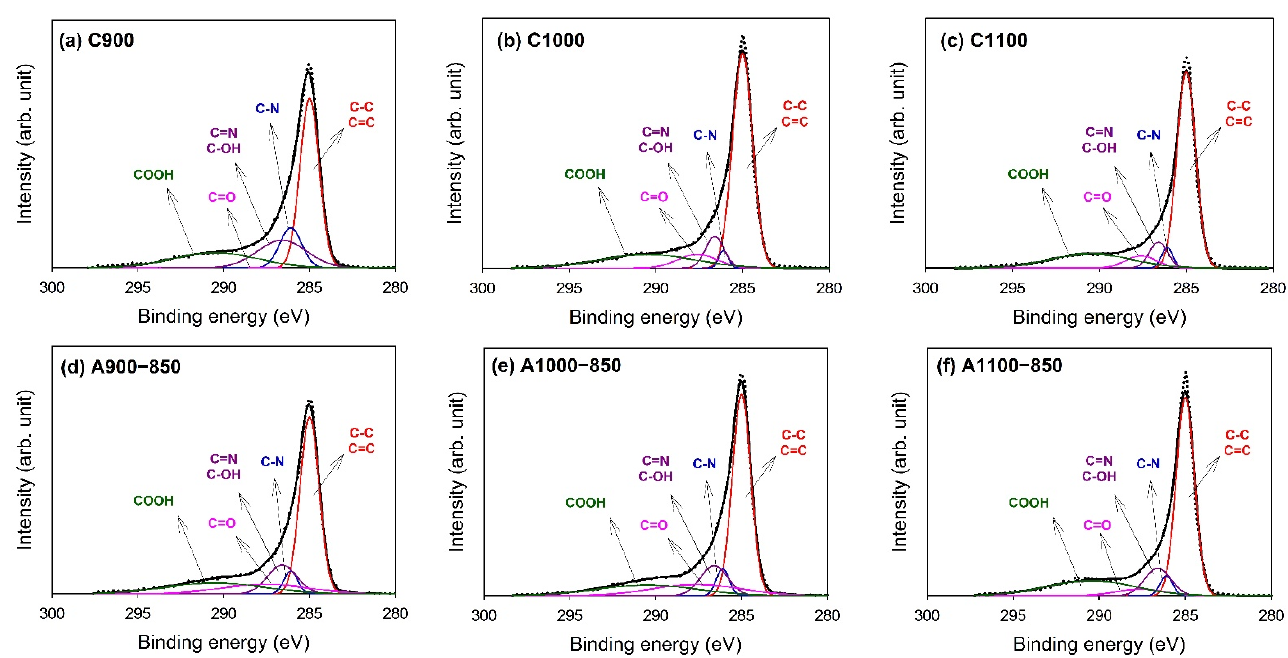
Figure 3. X-ray photoelectron spectroscopy (XPS) C 1s spectra: ( a ) C900; ( b ) C1000; ( c ) C1100; ( d ) A900 − 850; ( e ) A1000 − 850; and ( f ) A1100 − 850. The values are given in the atomic ratio (%) of total intensity. Table 2. Results of the fits of the XPS C 1s region, values given in at.% (percent of total intensity). Binding Energy